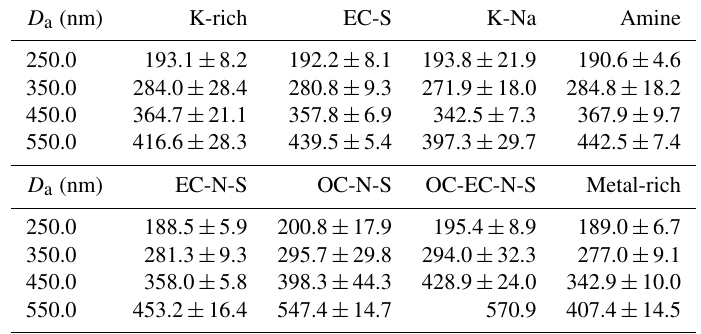
Table 1. The measured mean D ve and its standard deviation for the eight particle types at D a values of 250.0, 350.0, 450.0, and 550.0nm from nine rounds of measurements.